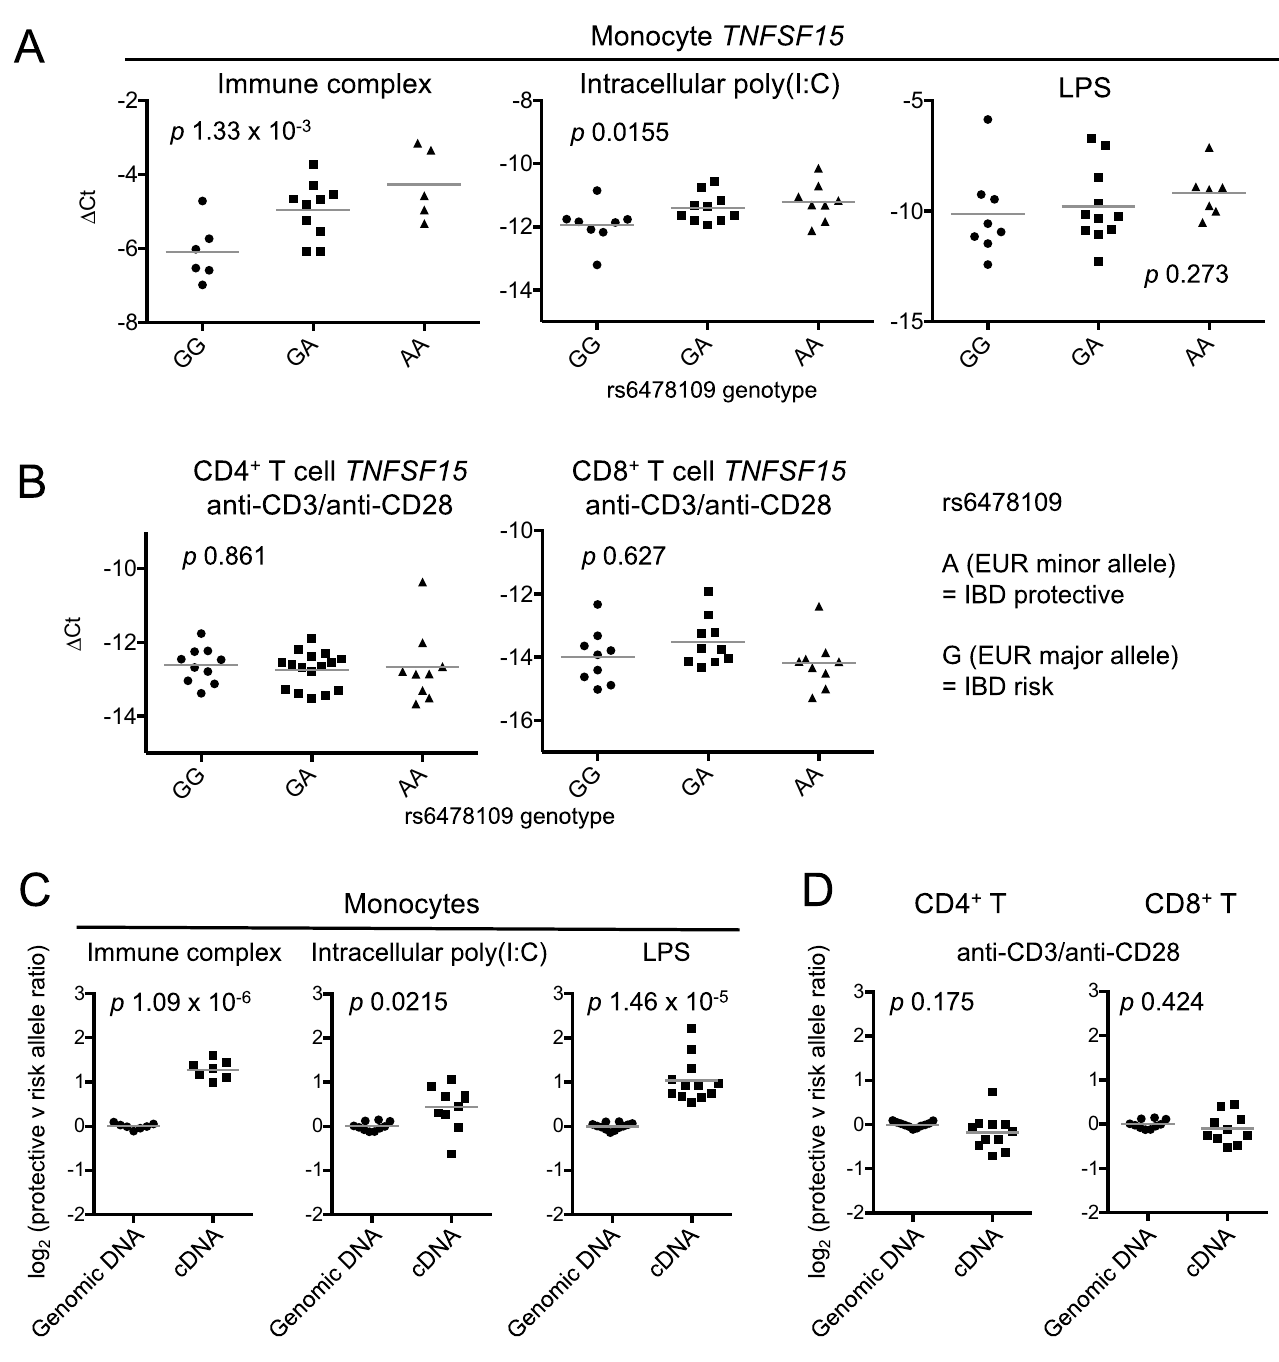
Fig 2. Monocyte but not T cell TNFSF15 expression is associated with genotype after stimulation. ( A ) TNFSF15 mRNA expression was measured relative to B2M in monocytes stimulated for 4 hours with immune complex (rs6478109 genotype: GG, n = 6; GA, n = 10; AA, n = 5), intracellular poly(I:C) (GG, n = 8; GA, n = 10; AA, n = 8), or LPS (GG, n = 8; GA, n = 11; AA, n = 7). Expression is reported as Δ Ct, each point represents an individual, lines represent mean values, and p values are from linear regression. ( B ) As (A) for CD4 + (GG, n = 10; GA, n = 16; AA, n = 9) and CD8 + (GG, n = 9; GA, n = 10; AA, n = 9) T cells stimulated for 24 hours. ( C ) Allelic ratios in cDNA from stimulated cells from heterozygous individuals are compared with those in genomic DNA from the same individuals: monocytes stimulated with immune complex (n = 7), intracellular poly(I:C) (n = 10) and LPS (n = 12), and ( D ) anti-CD3/anti-CD28-stimulated CD4 + (n = 11) and CD8 + (n = 10, genomic DNA as for panel (C) intracellular poly(I:C)) T cells. Ratios for immune complex- and LPS-stimulated monocytes and stimulated CD4 + T cells were measured using tag SNP